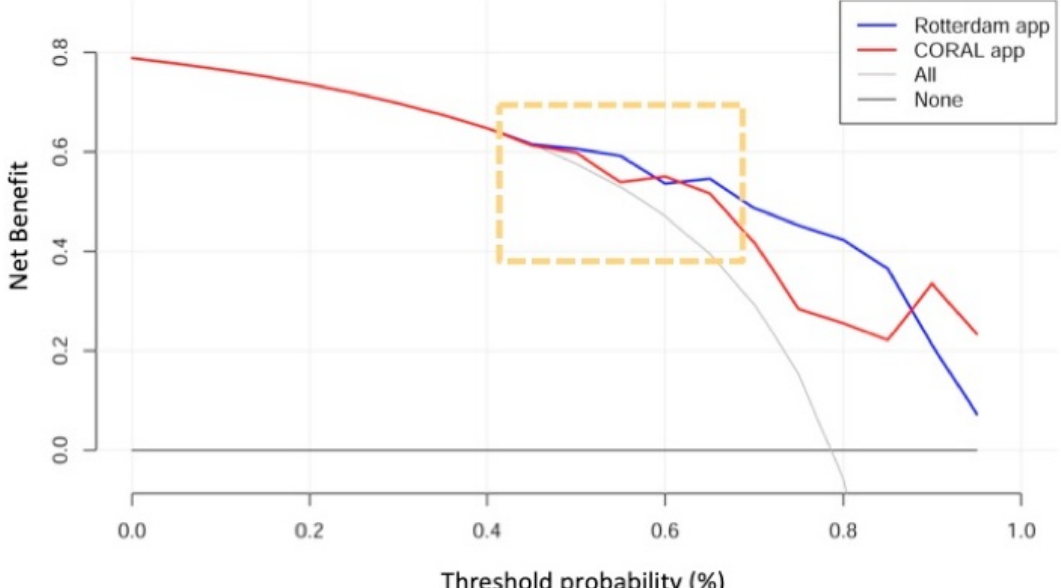
Figure 5. Decision curve analysis showing the net benefits of utilizing the Rotterdam app (blue line) and the Coral app (red line) to detect high-grade prostate cancer (PCa) in the prostatectomy cohort. The curves are skewed because the incidence of high-grade PCa in the prostatectomy cohort